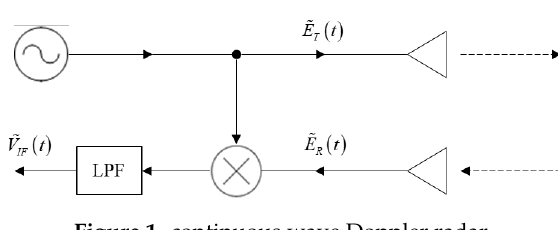
Figure 1. continuous wave Doppler radar.